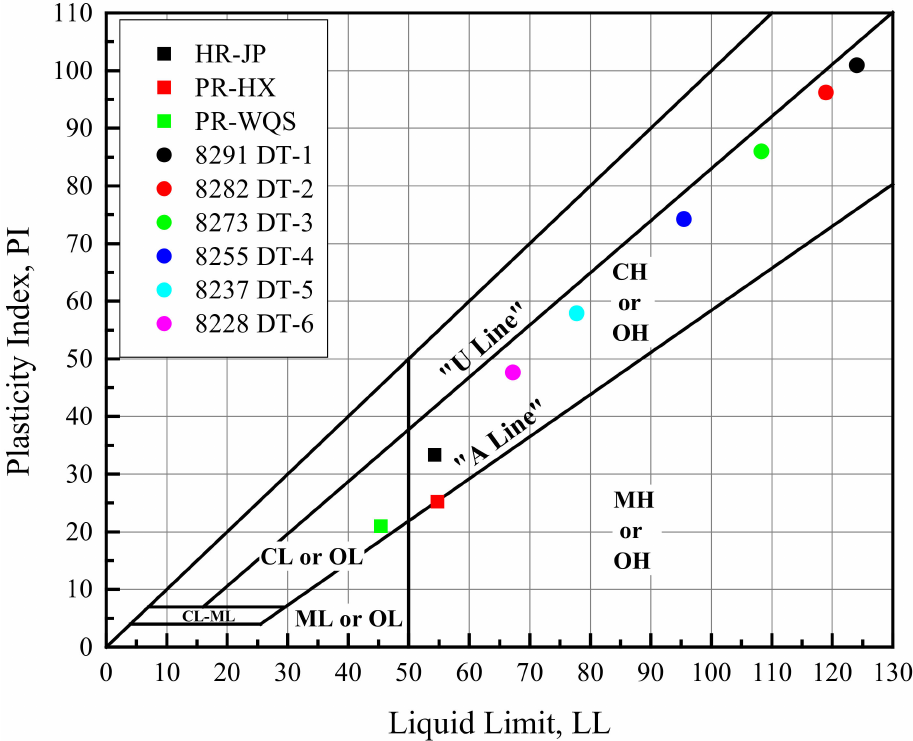
Figure 4. Plasticity chart of natural and artificial marine